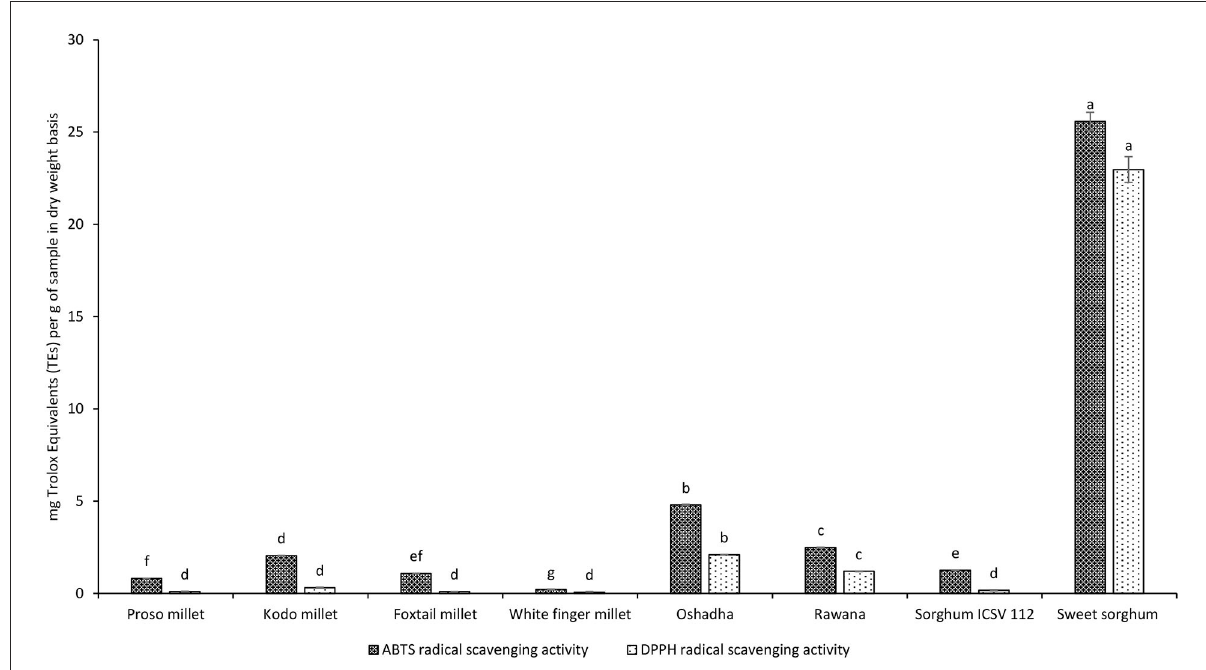
FIGURE10 Screening of selected millet types and sorghum varieties for ABTS and DPPH radical scavenging activities. ABTS and DPPH radical scavenging activities have been separately analyzed. Different letters on bar graphs are significantly different at P <